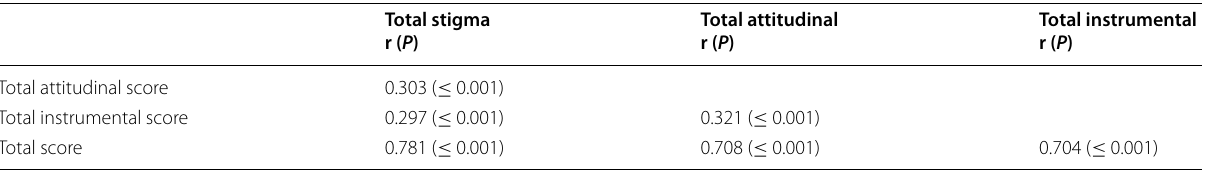
Total attitudinal r ( P )